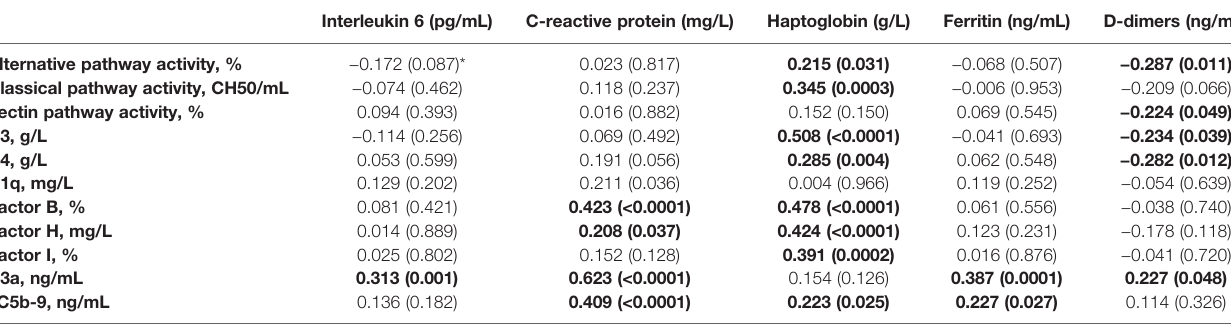
TABLE 3 | Correlation between complement parameters and markers of in fl ammation and fi